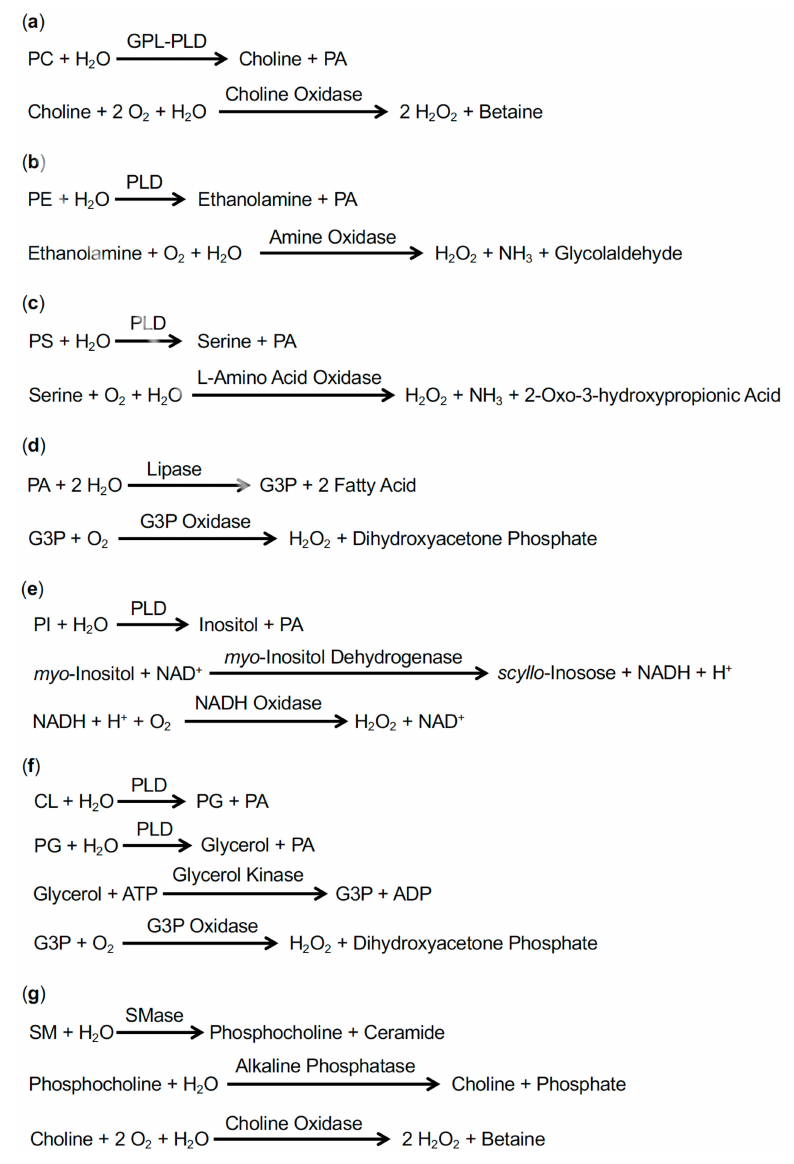
Figure 3. Strategies for enzymatic fluorometric measurements of PC ( a ), PE ( b ), PS ( c ), PA ( d ), PI ( e ), PG + CL ( f ), and SM ( g ). In the final steps, H 2 O 2 is detected using Amplex Red and